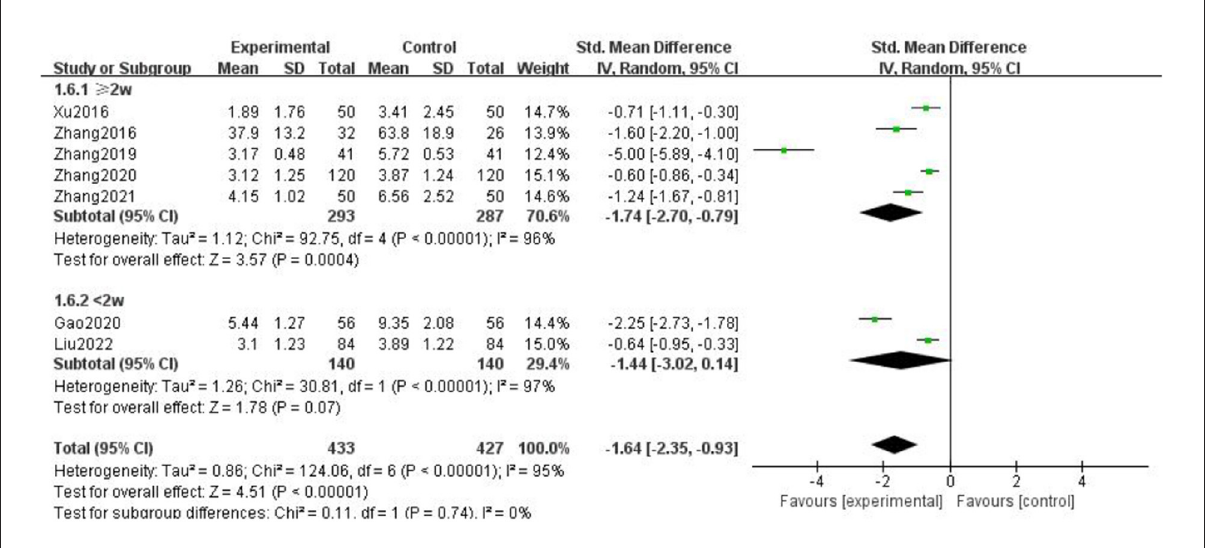
FIGURE7 Forest chart of headache duration divided into subgroups according to course of treatment.